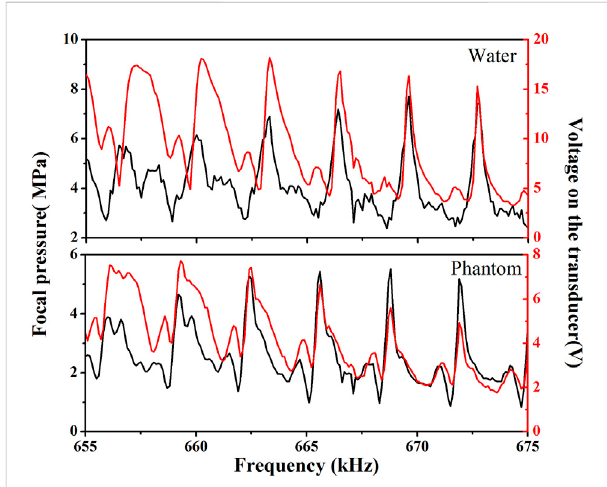
FIGURE 6 The frequency-dependent acoustic pressure at the focus (black) and voltage signal of the spherical cavity transducer (red) for SW focusing through water (upper panel) and through Phantom (lower